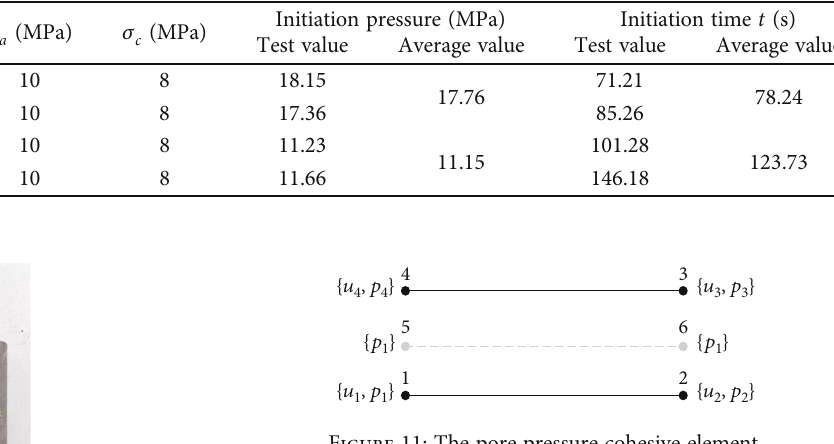
Table 2: Hydraulic and ScCO